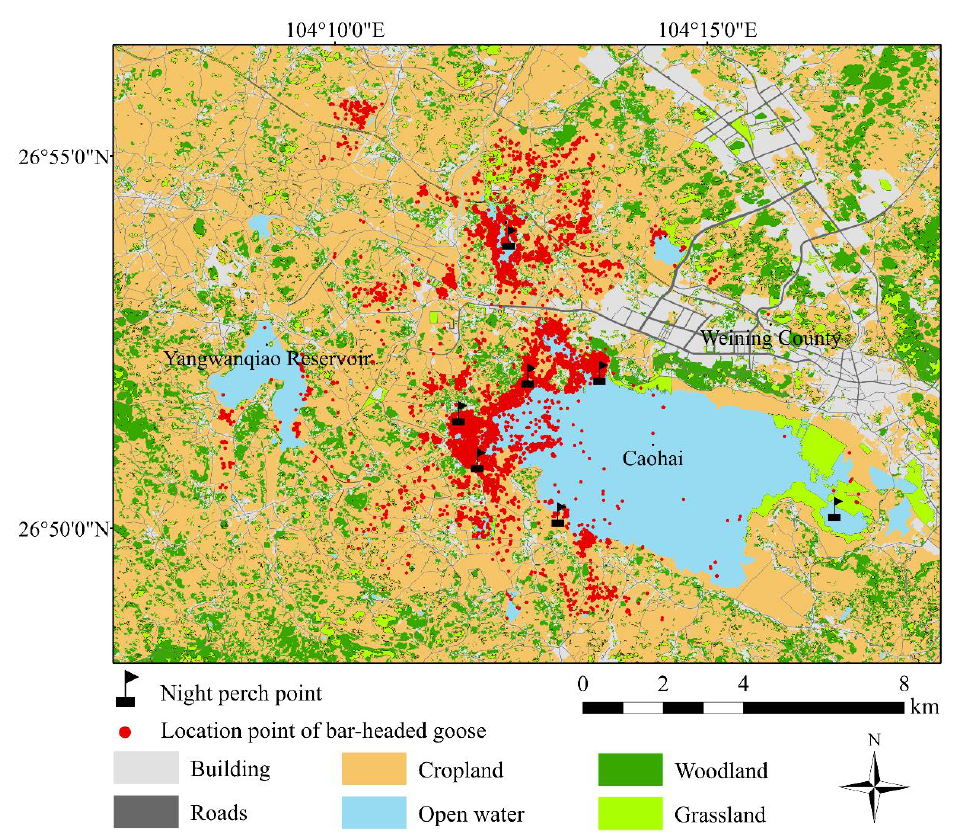
Figure 1. Location of 19 individual bar-headed geese derived from satellite tracking over a 13-month period in Caohai, with land use types indicated on the map.